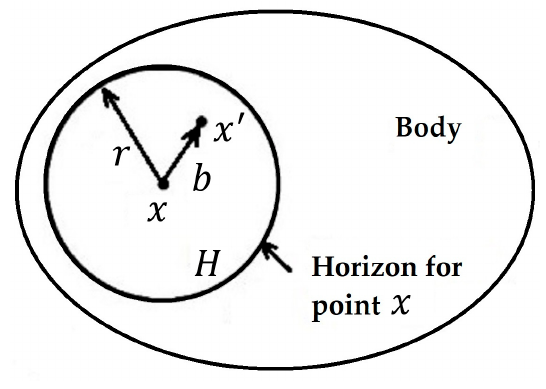
Figure 9. Peridynamics model.